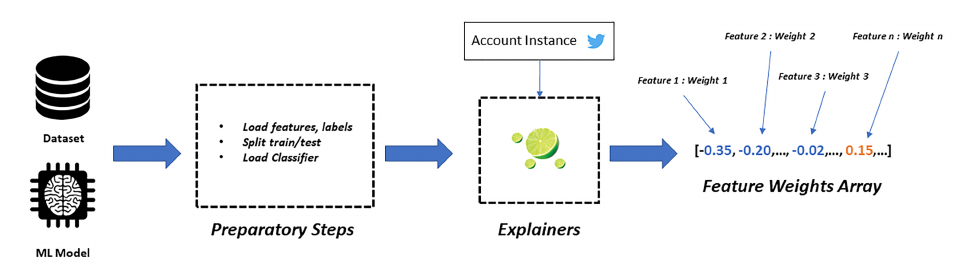
Figure 9. The explainability